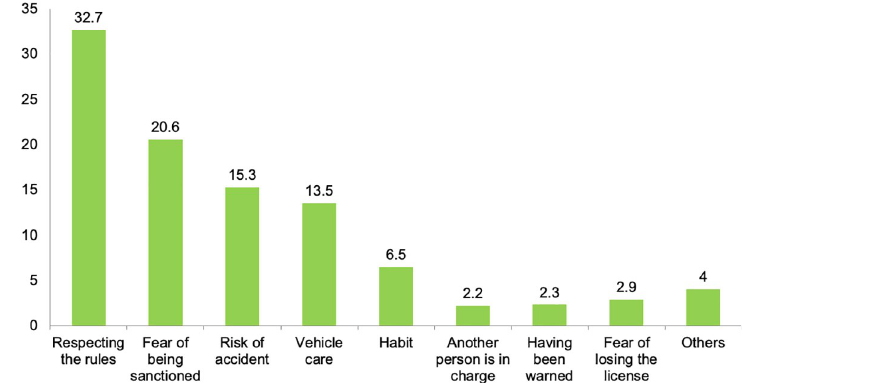
Fig 1. Driver’s reasons to comply with vehicle technical inspection’s (VTI) standards.